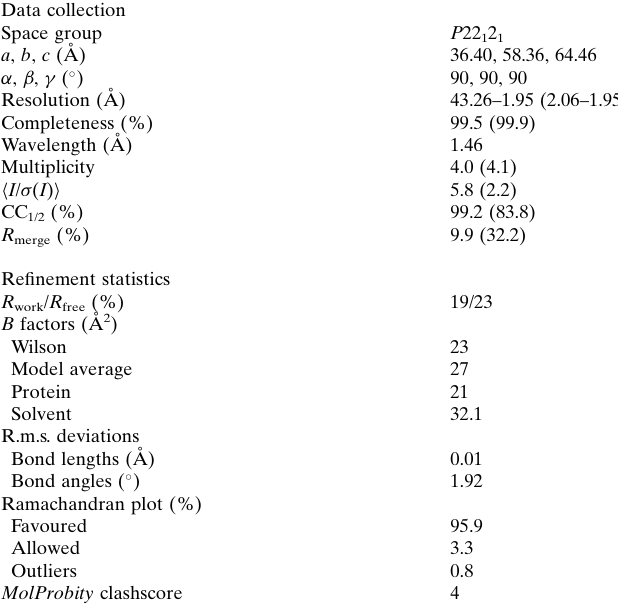
Table 2 Data-collection and structure-refinement parameters for PLA2 from B. atrox . Lowest-resolution-shell values are given in brackets.